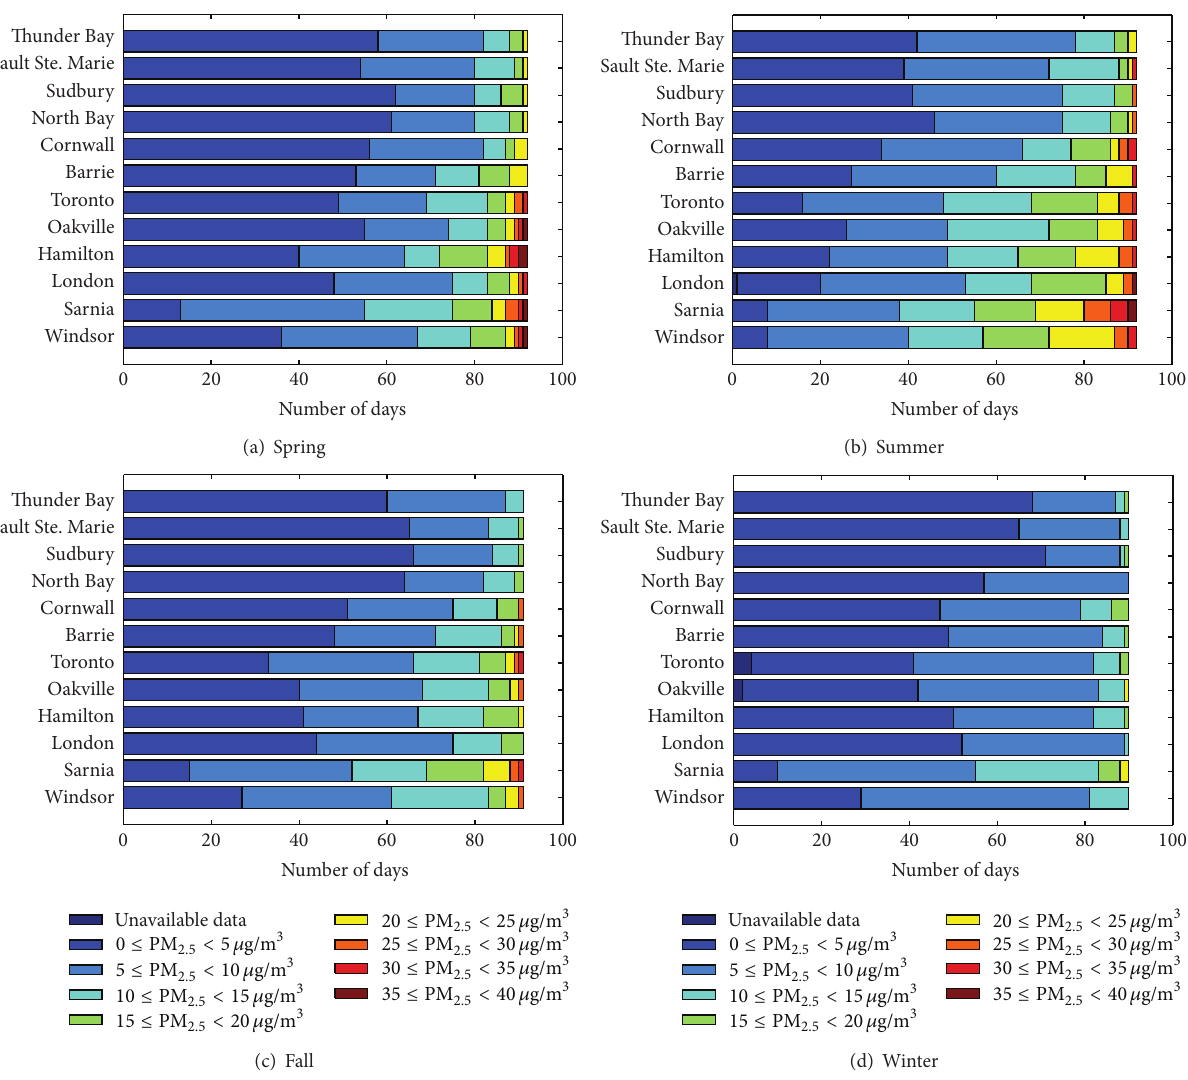
Figure 4: The number of days for daily PM 2.5 at 7 levels in spring, summer, fall, and winter at the 12 Ontarian cities in 2006. The cities are ordered by descending latitude (see Table 1 and Figure